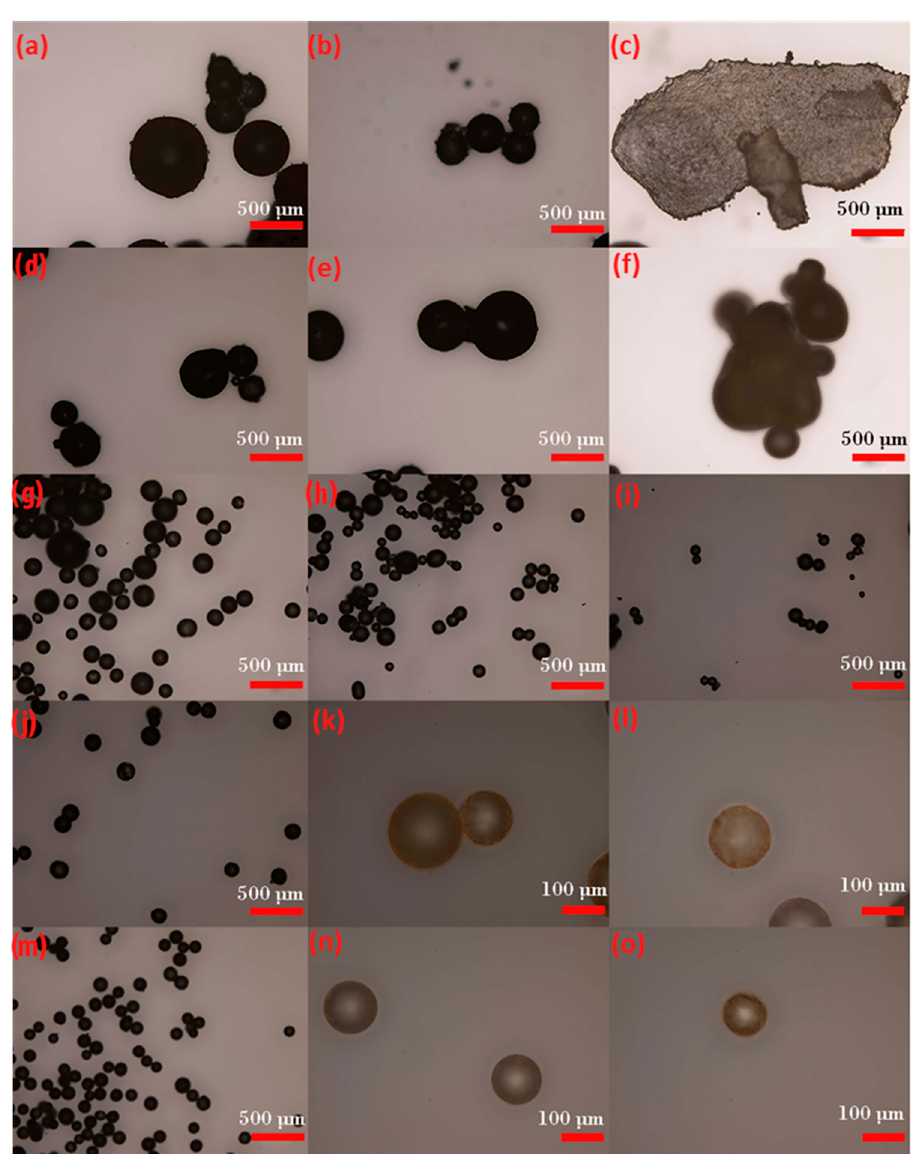
Figure 3. Optical images of Sample 3 ( a – c ), Sample 4 ( d – f ), Sample 5 ( g ), Sample 6 ( h ), Sample 7 ( i ), Sample 8 ( j – l ), and Sample 9 ( m – o ). Sample 8 ( j – l ), and Sample 9 ( m – o